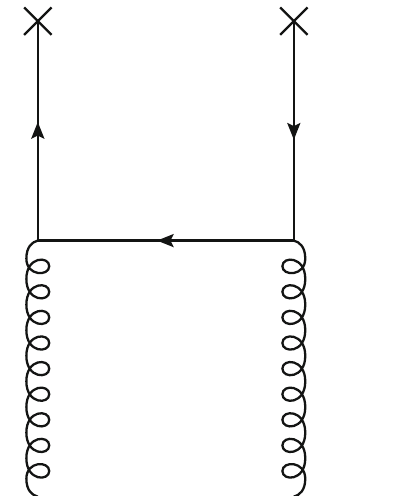
Fig. 7 One-loop diagrams for quark splitting to gluon